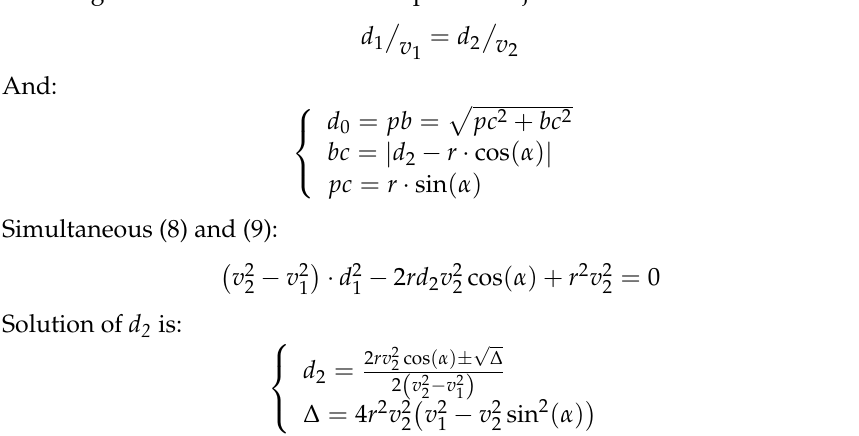
Figure 4. Model observation map.